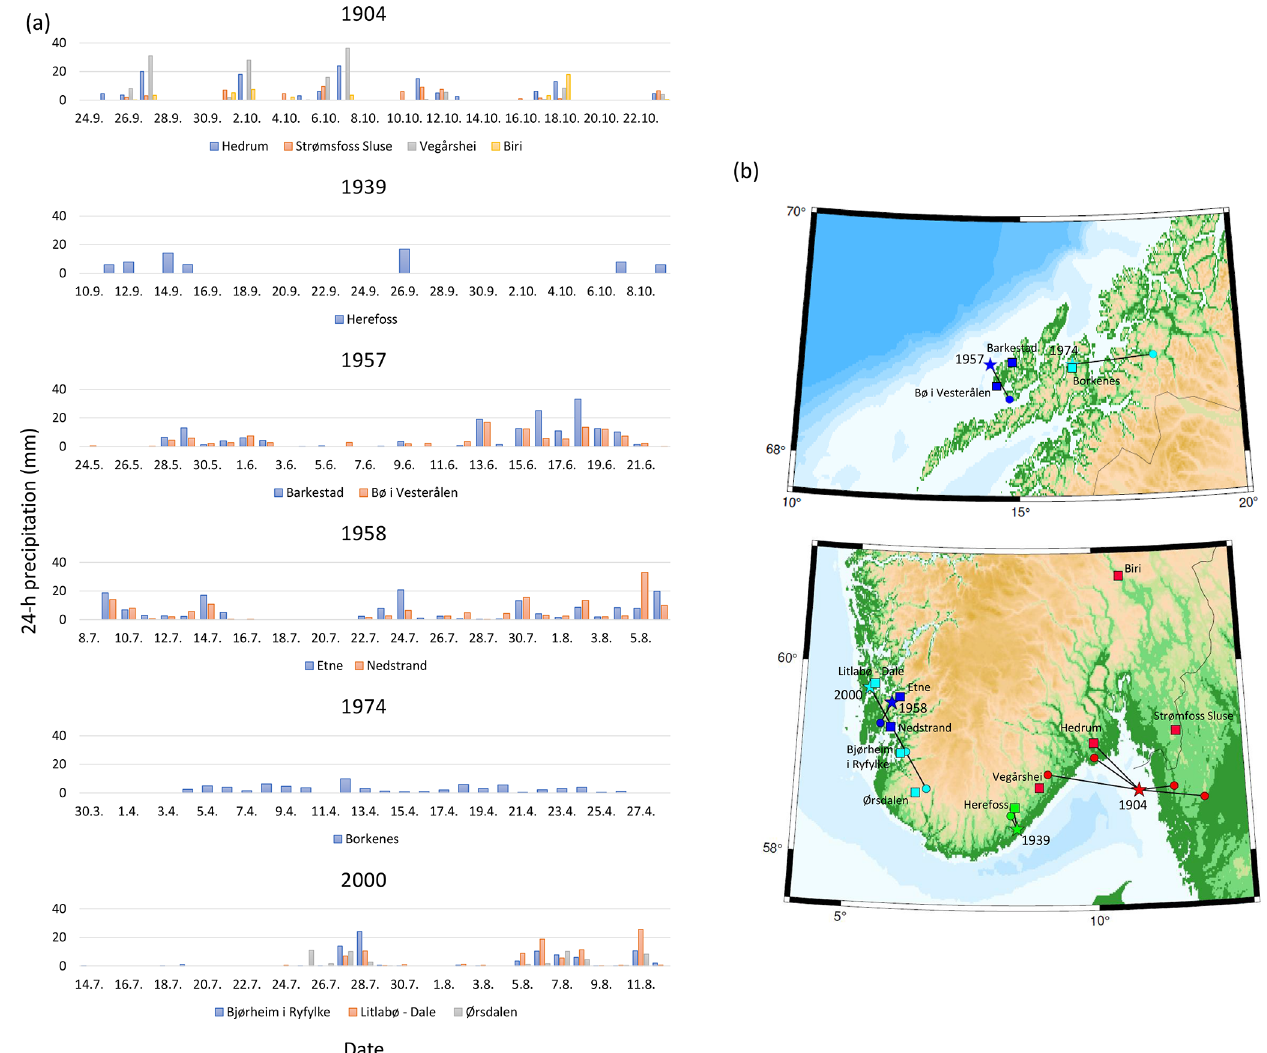
Figure 6. (a) Precipitation observed 30d before the earthquakes inducing landslides. (b) Locations of the weather stations shown in (a) (squares), earthquake epicentres (stars) and EQILs (circles). Lines connect EQILs to the epicentre of their triggering earthquake. Colours are the same for data referring to a given